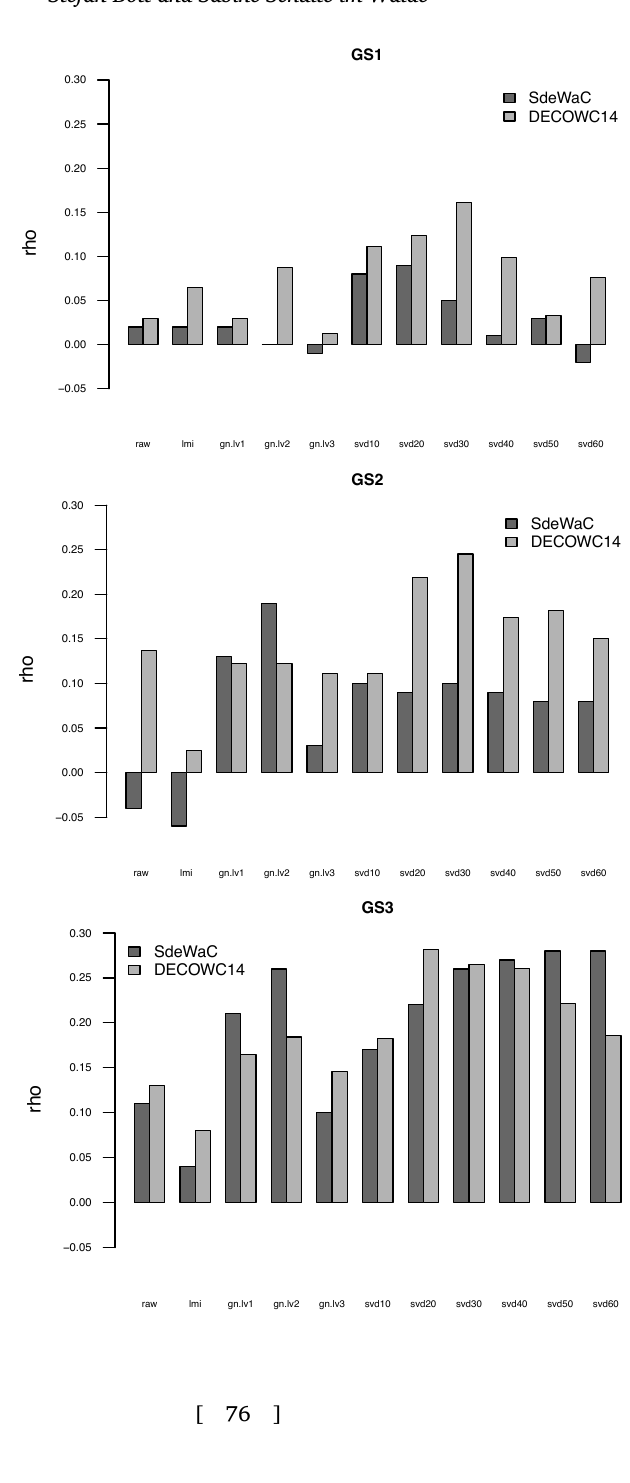
Results for syntactic models extracted from two different corpora: SdeWaC vs.